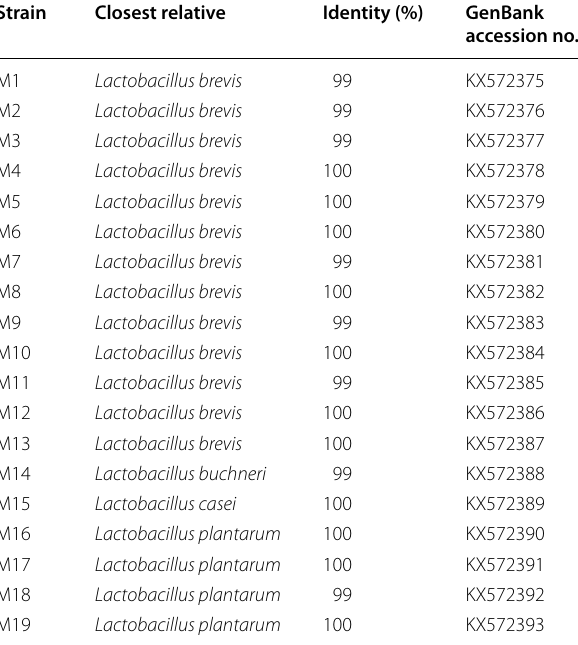
Table 4 Identities of pure